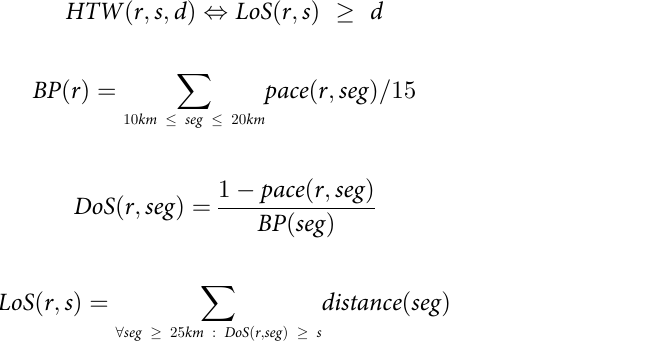
an imperfect measure of whether a runner truly hits the wall. It will both overestimate and underestimate the true number who hit the wall; for example, some runners will slow due to injury or lack of training/fitness, rather than because they genuinely hit the wall, while others may hit the wall too late in the race to be identified. Nevertheless, this approach should be suf- ficient to provide an estimate that is good enough to use at scale in this analysis. More formally, we determine a runner r to have hit the wall (Eq 1) when they slow by at least a factor of s –– their degree of slowdown or DoS –– for at least d kms –– their length of slowdown or LoS –– after the 20km mark; that is, for segments from the 25km segment (20– 25km) to the final segment. To calculate a runner’s degree of slowdown for a given race seg- ment we use their base-pace ( BP ) as a reference pace. Their base-pace is their average pace dur- ing the 5km–20km portion (that is, the 3 × 5 km segments, 5–10km, 10–15km, and 15–20km) of the race, as shown in Eq 2; we exclude the initial 5km segment because pacing during the very early stages of the marathon tends to be more erratic [10] as it can take time for runners to locate their desired pace after a congested start. Then, the degree of slowdown is based on the ratio of their second-half segment paces to their base-pace, as shown in Eq 3. For example, if r has a base-pace of 5 mins/km and they slow to 6 mins/km during the 30–35km segment, then their degree of slowdown for this segment will be 0.2. Finally, we can calculate the length of a slowdown ( LoS ) as the sum of the distances for any second-half segments in which the runner slows by at least s ; see Eq 4.